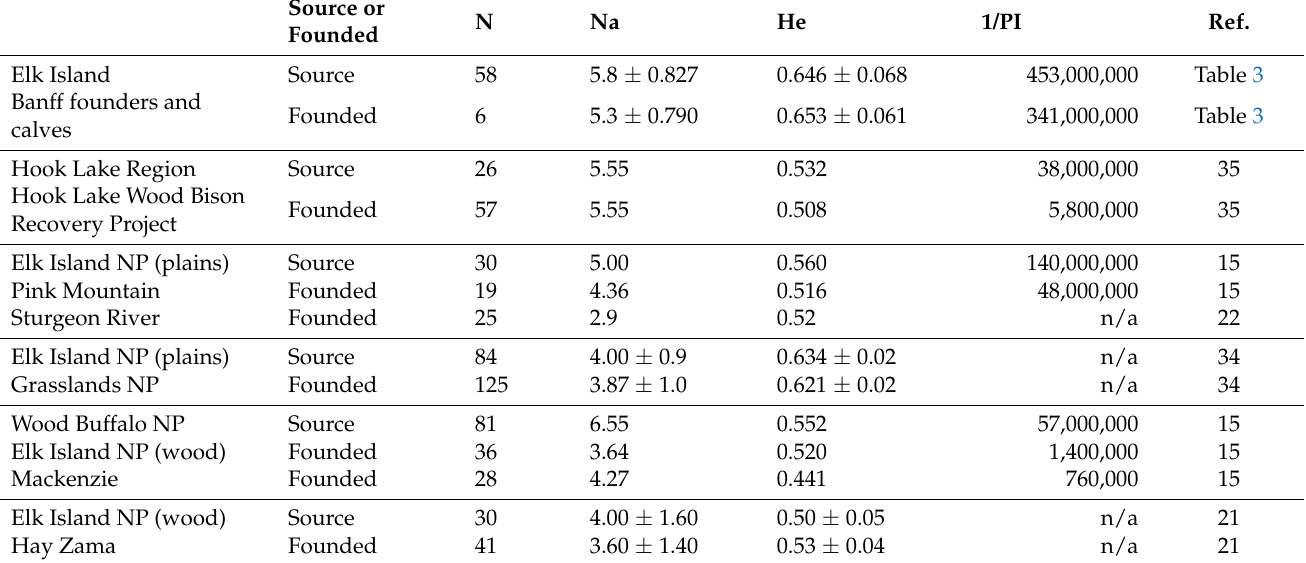
Table 4. Genetic diversity in a number of source and founded bison herds from previously published studies. Na, mean number of alleles; Ho, observed homozygosity; He, expected heterozygosity; PI, probability of identity. Standard errors are not available for all studies. Note that the samples and microsatellite loci used and analyses performed may vary among studies, which is why the diversity for the Elk Island NP (plains) population is listed multiple times and differs across